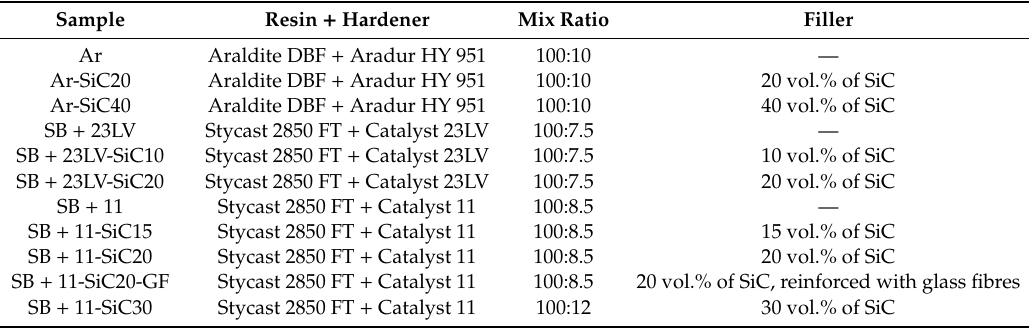
Table 2. Overview of all composites used for preparation of bulk samples and coated coated conductor (CC)